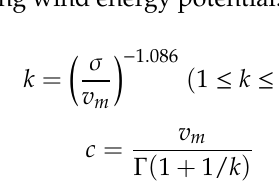
Figure 6. Wind speed frequencies at 90 m height at newly proposed wind farm sites ( a ) Site 1; ( b ) Site 2; ( c ) Site 3; ( d ) Site 4; ( e ) Site 5; ( f ) Site 6; ( g ) Site 7; ( h ) Site 8; ( i ) Site 9; ( j ) Site 10. Weibull-shape parameter ( k ) and scale factor ( c ) are two of the most important parameters that